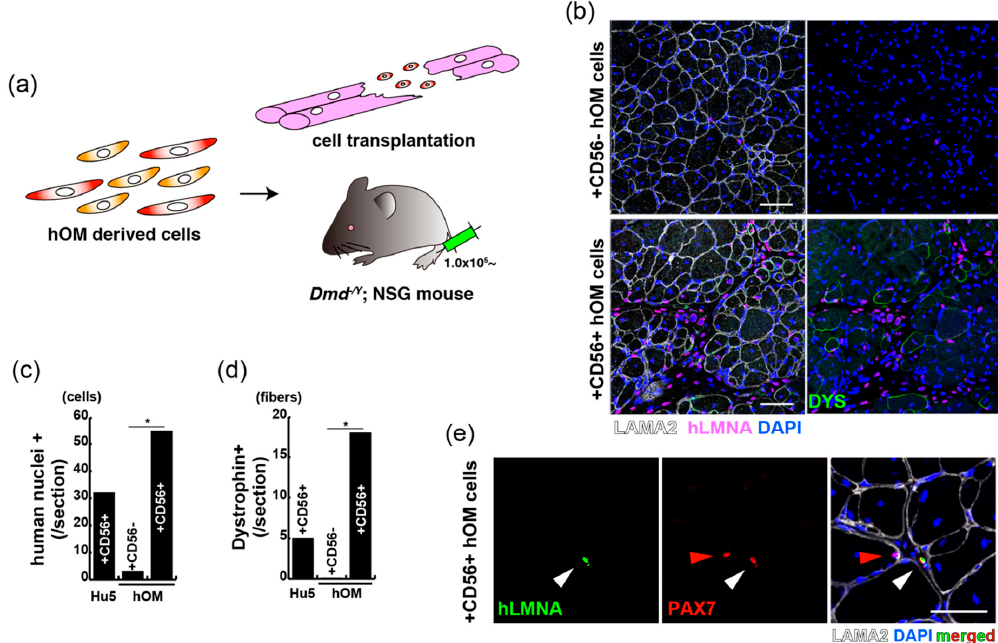
Figure 5. CD56-positive cells from orbicularis oculi muscle have regenerative capacity for Duchenne muscular dystrophy model mice. ( a ) A schematic model for the transplantation with sorted cells of orbicularis oculi muscle (hOM) into DMD-null ( Dmd - / y ) and NSG mice. ( b ) Immunostaining for LAMININ alpha-2 (LAMA2, labelled with Alexa647, white), human nuclear LAMIN A / C (hLMNA, labelled with Alexa594, pink), and DYSTROPHIN (DYS, labelled with Alexa488, green) in tibialis anterior (TA) muscles of Dmd - / y . NSG mice were injected with CD56-negative (upper panels) or CD56-positive (lower panels) cells derived from the orbicularis oculi 2 weeks after intramuscular engraftment. Total nuclei were stained with DAPI (blue). Scale bar, 50 µ m. ( c ) The quantification